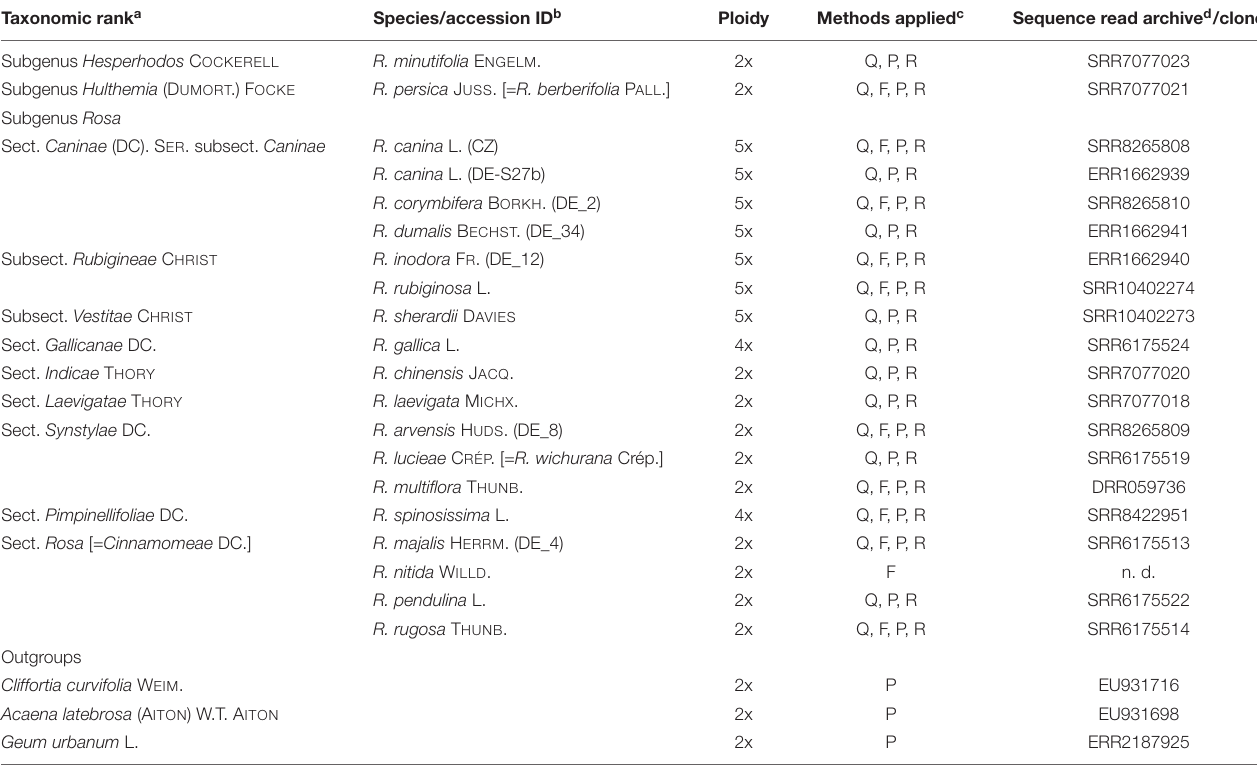
TABLE 1 | List of Rosaceae species used in this study, ploidy, source, and read archive accessions and the analyses